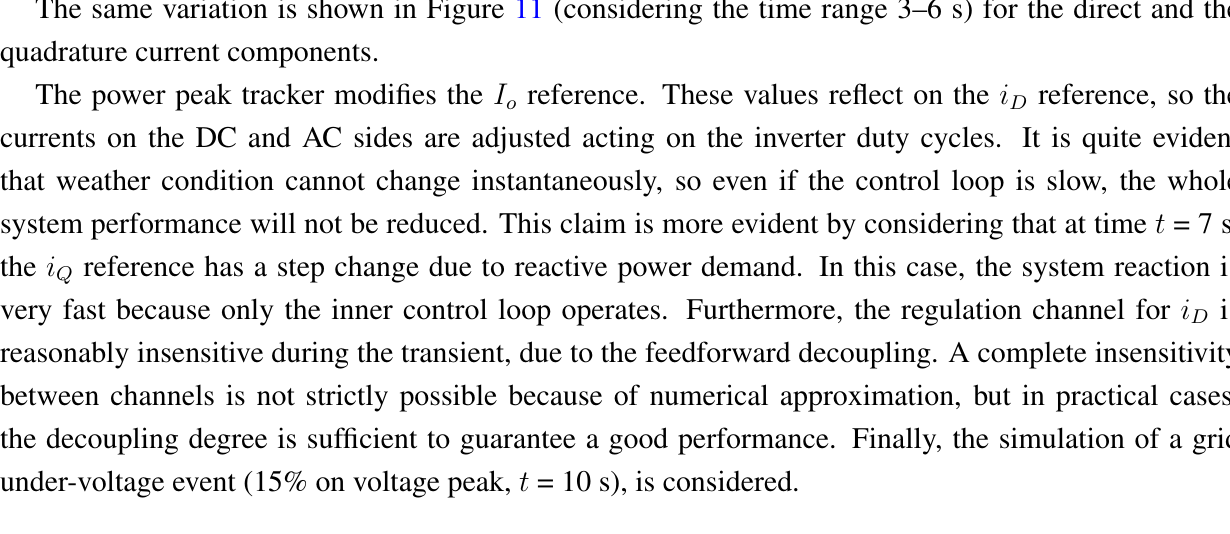
Figure 11. Direct and quadrature components of the AC side currents during transients (change of i reference from MPPT and change of D